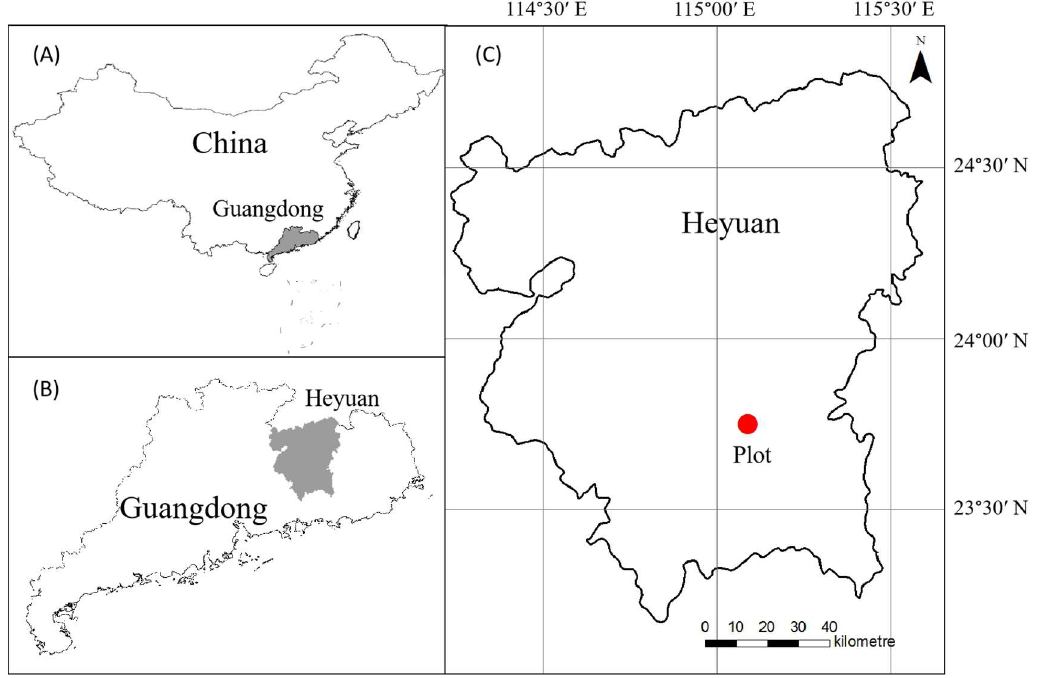
Figure 1. Geographic location of the study area in Guangdong, China ( A,B ) and the plot ( C ).